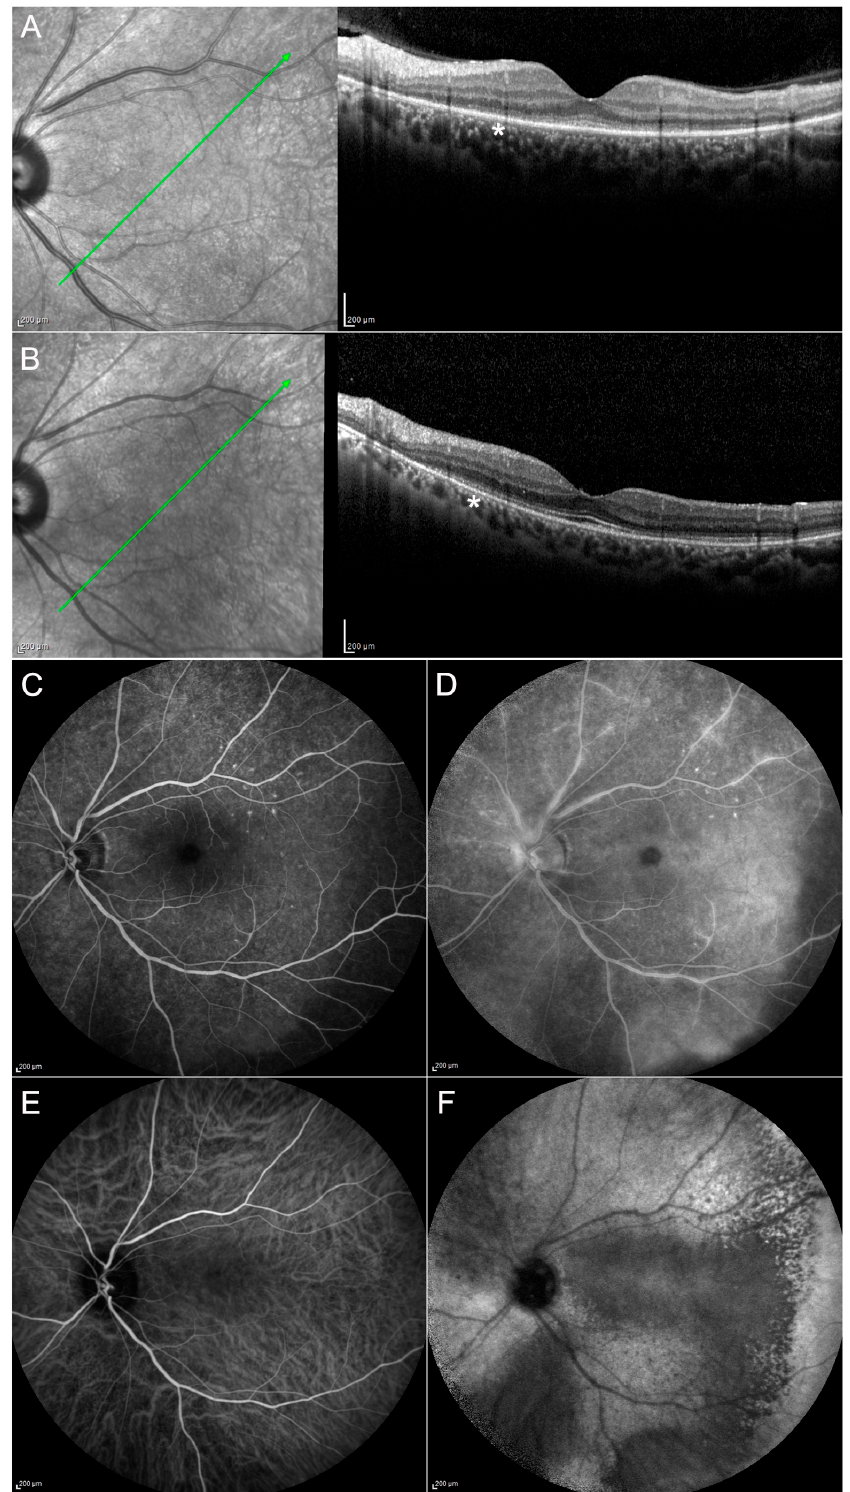
Figure 3. Case 1, acute syphilitic posterior placoid chorioretinitis (ASPCC). Patients affected by ASPCC show typical outer retinal abnormalities on OCT with ellipsoid zone disruption ( A ) ( asterisk ), partially resolved after the treatment ( B ). FA reveals early hypofluorescence and late hyperfluorescence corresponding to the lesions ( C,D ). ICGA shows hypocyanescence until the late stages of the examination ( E,F ). Green arrow: plane and orientation of the optical coherence tomography (OCT) line scan.